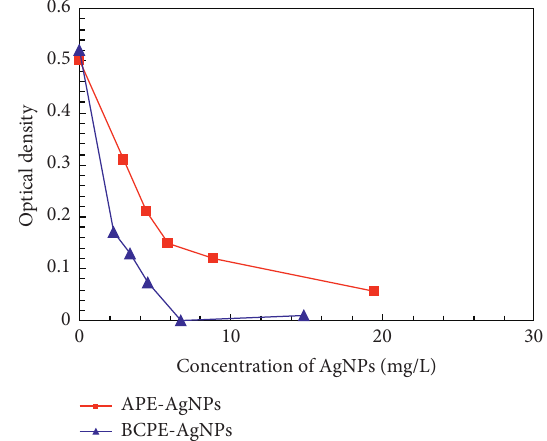
Figure 9: Optical density of test tubes with E. coli culture and different concentration of AgNPs obtained with apricot (1) and black current (2) pomace extracts after 24-hour cultivation.